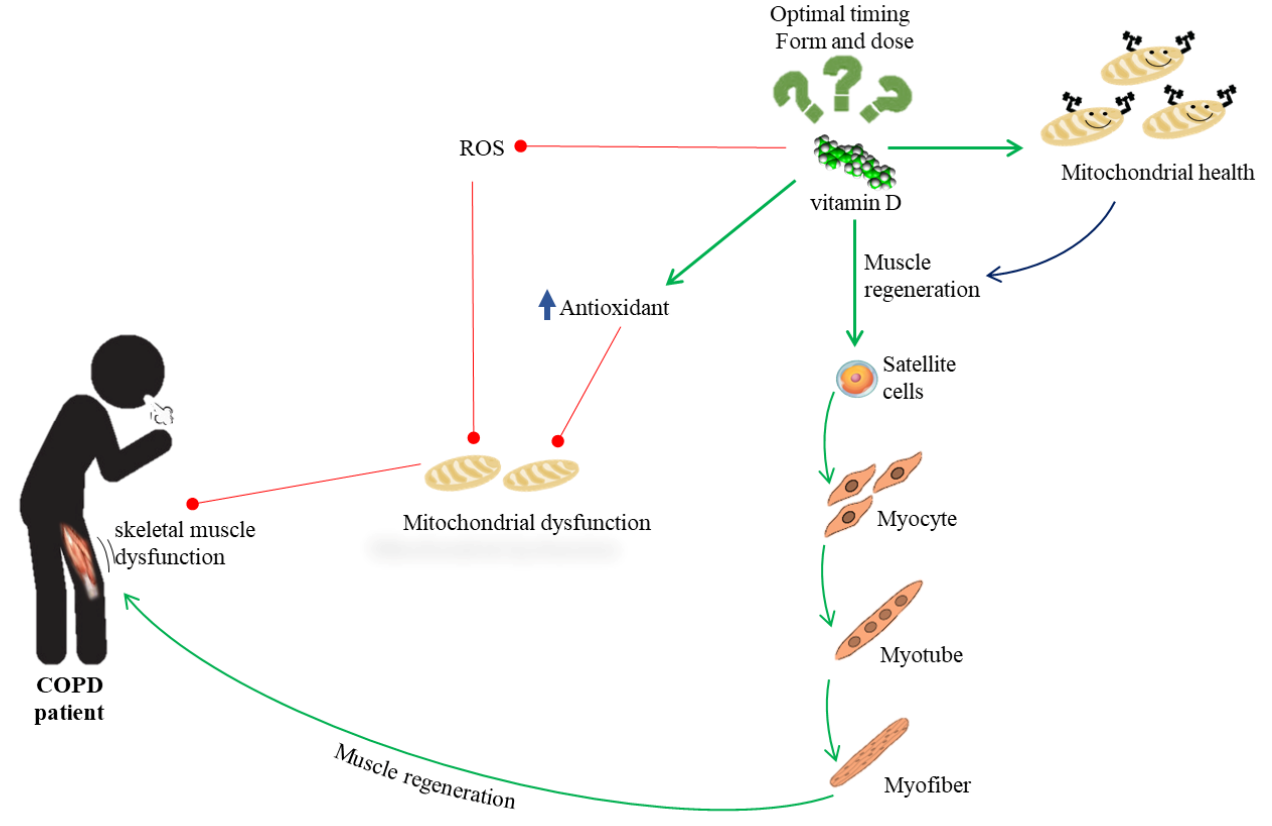
Figure 3. Overview of the possible role of vitamin D activity in patients with COPD suffering from skeletal muscle dysfunction.